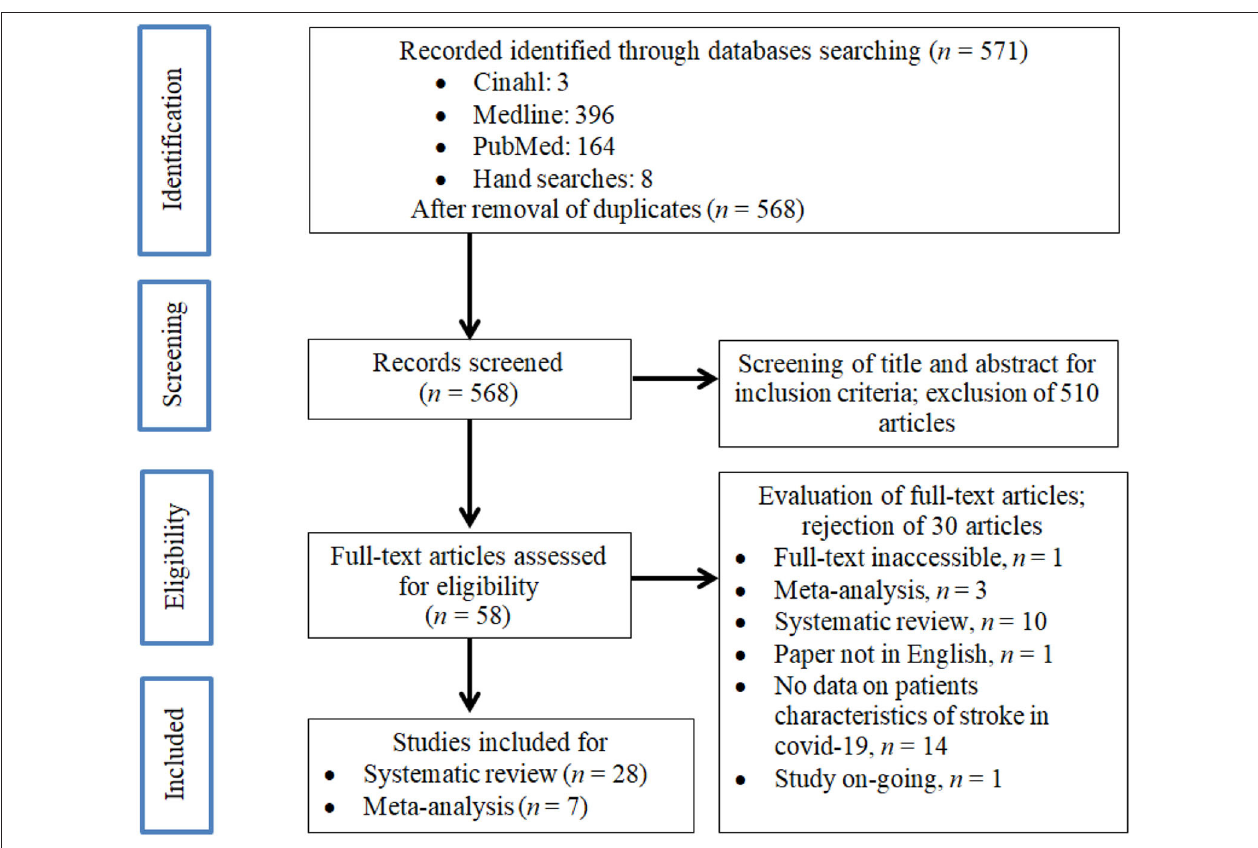
FIGURE 1 | PRISMA flow diagram of the literature screening process.